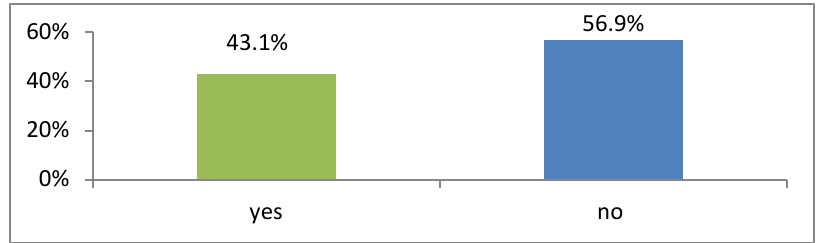
Figure 4. Respondents’ responses to whether their requests for days off are considered (N = 197).